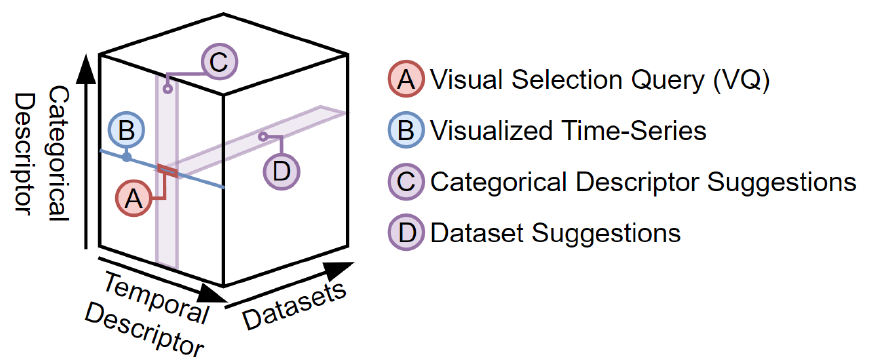
Figure 3. Example of the two suggestion lists given the dataset collection and the user’s VQ (A) of the visualized time-series (B). Q4EDA calculates and outputs two suggestion lists: a dataset list indicating similar datasets to the VQ given the same time-range and categorical descriptor, and another list indicating similar categorical descriptors (e.g., country) to the VQ given the same time- range and